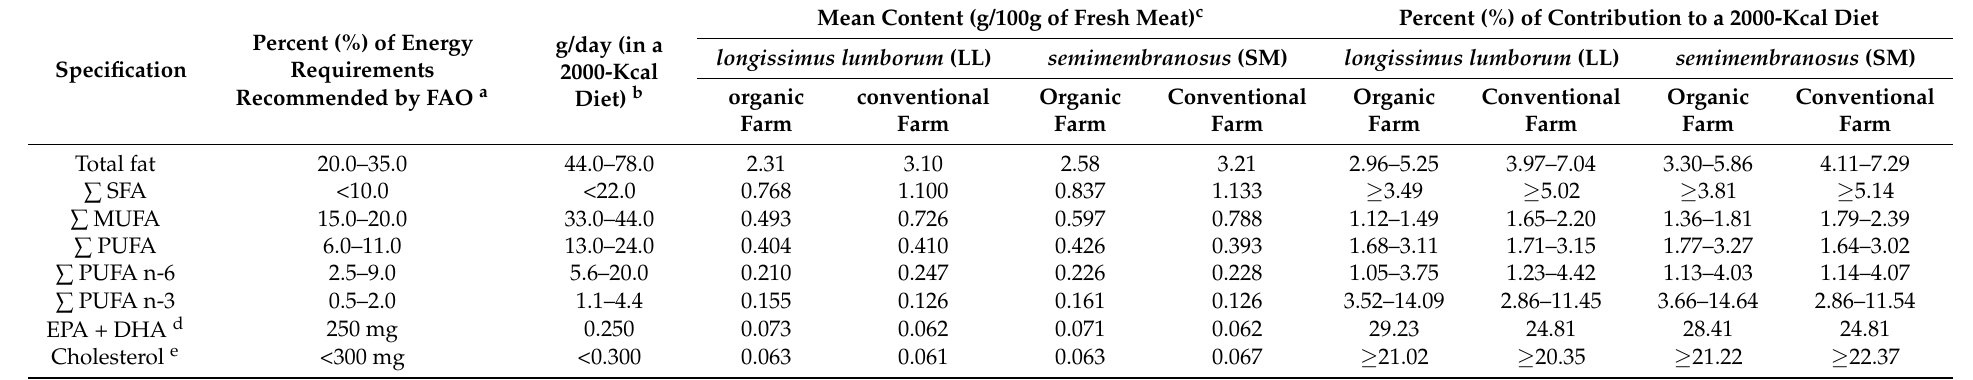
Table 3. Contribution of a 100-g portion of fallow deer meat in the diet of adults in terms of total fat, fatty acids, and